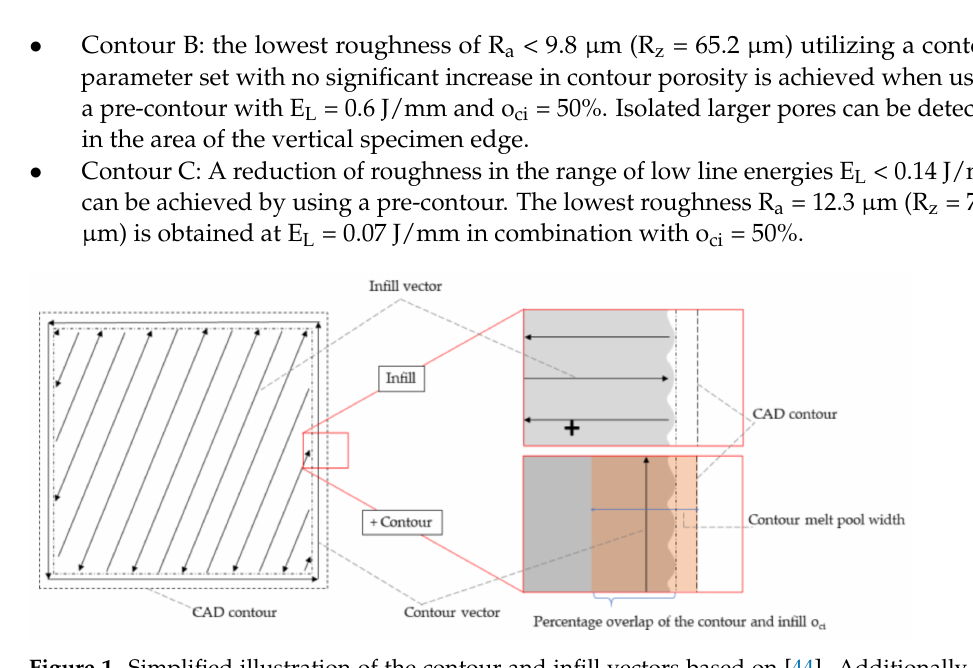
Figure 1. Simplified illustration of the contour and infill vectors based on [44]. Additionally, the percentage overlap of the contour scan and the infill o ci depending on the contour melt pool width is illustrated.